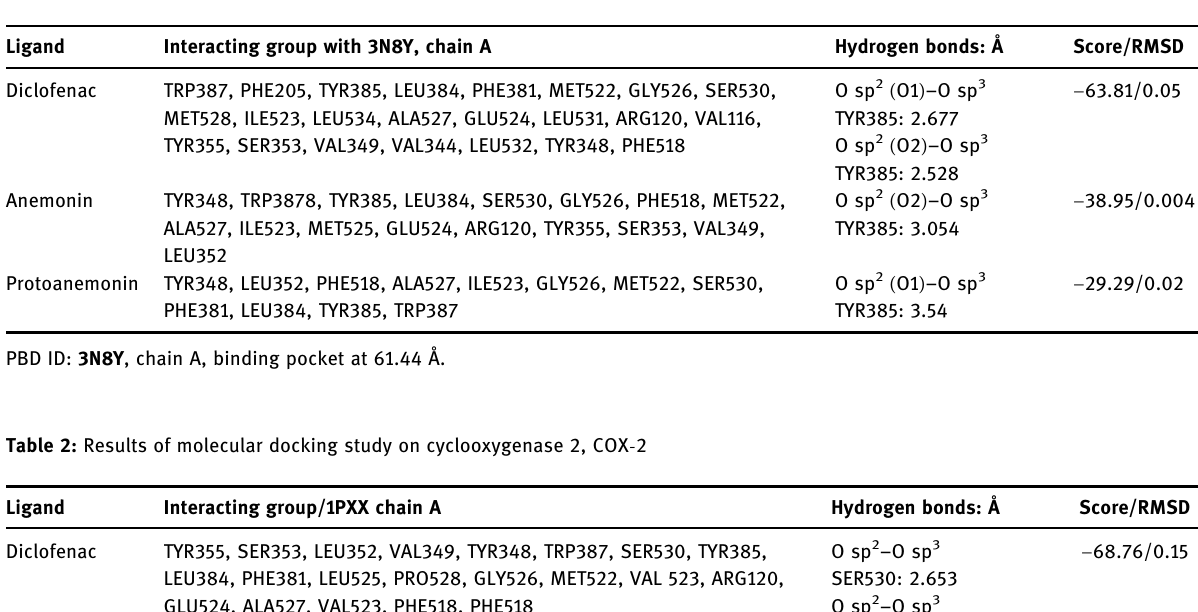
Table 1: Results of molecular docking study on cyclooxygenase 1, COX - 1 ( PDB ID: 3N8Y, chain A, binding pocket at 61.44 Å 3 )